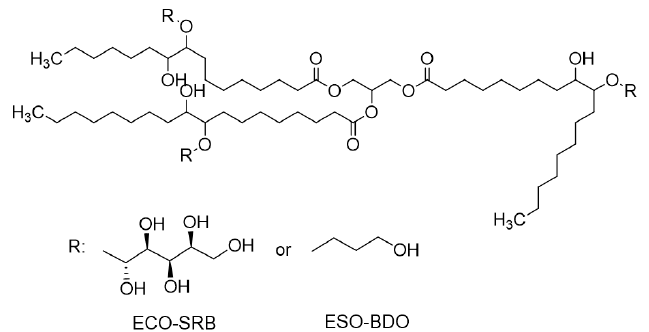
Figure 3. Schematic representation of products obtainable from the ring opening of the epoxidized triolein. As in the case of Figure 2, the structure does not represent the actual chemical complexity of the composition of cardoon seed oil; rather, it aims at simplifying the illustration of the concept. Codes refer to marine biodegradation tests.